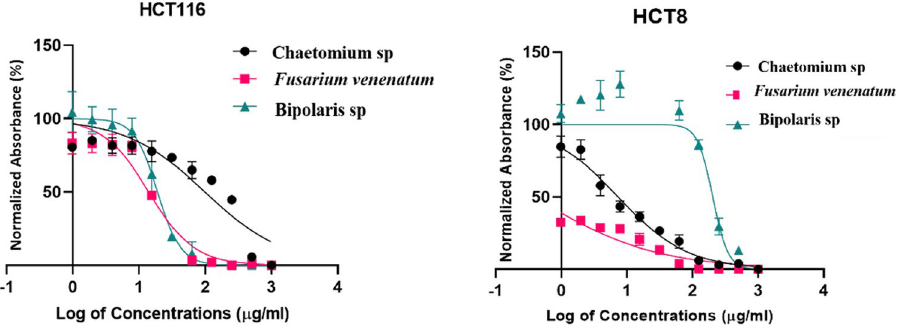
Figure 5. Dose–response manner and the inhibition curve of the three tested crude extracts on different colorectal carcinoma cells.